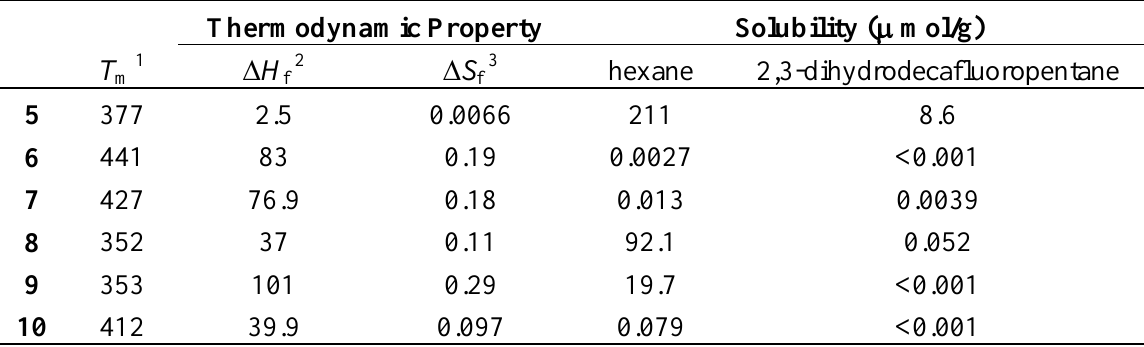
Table 1. Solubilities, melting points, and thermodynamic properties of Eu(III) complexes with  -diketonates and phosphine